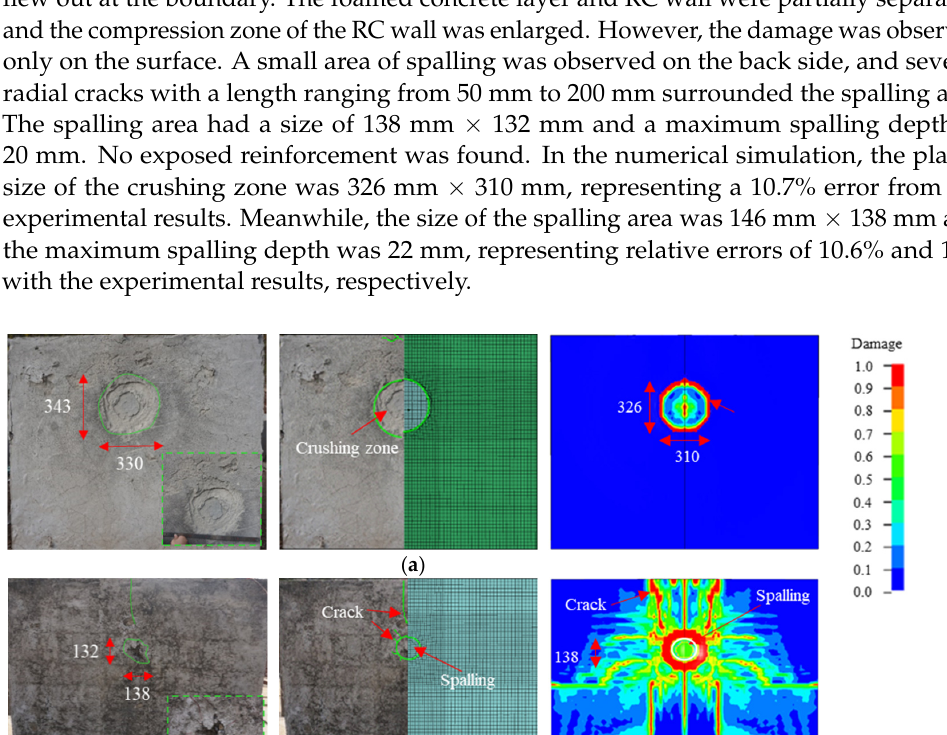
Table 7. Damage parameters of foamed concrete-coated RC walls.